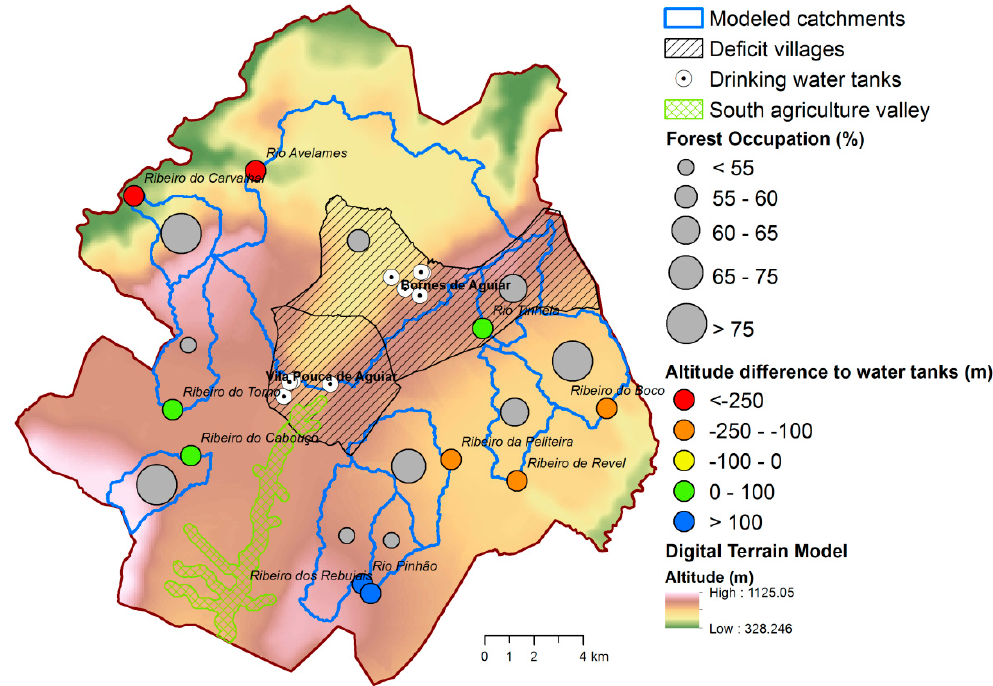
Figure 10. Percentage of forest cover (graduated grey circles) in the modeled catchments represented by the blue boundaries. Altitude differences between catchment outlets and the drinking water tanks (colored circles) located in the deficit villages of Vila Pouca de Aguiar and Bornes de Aguiar/Pedras Salgadas represented by the black shaded areas. The South Valley used extensively for agriculture is represented by the green shaded area. All this information is plotted over the municipal digital terrain